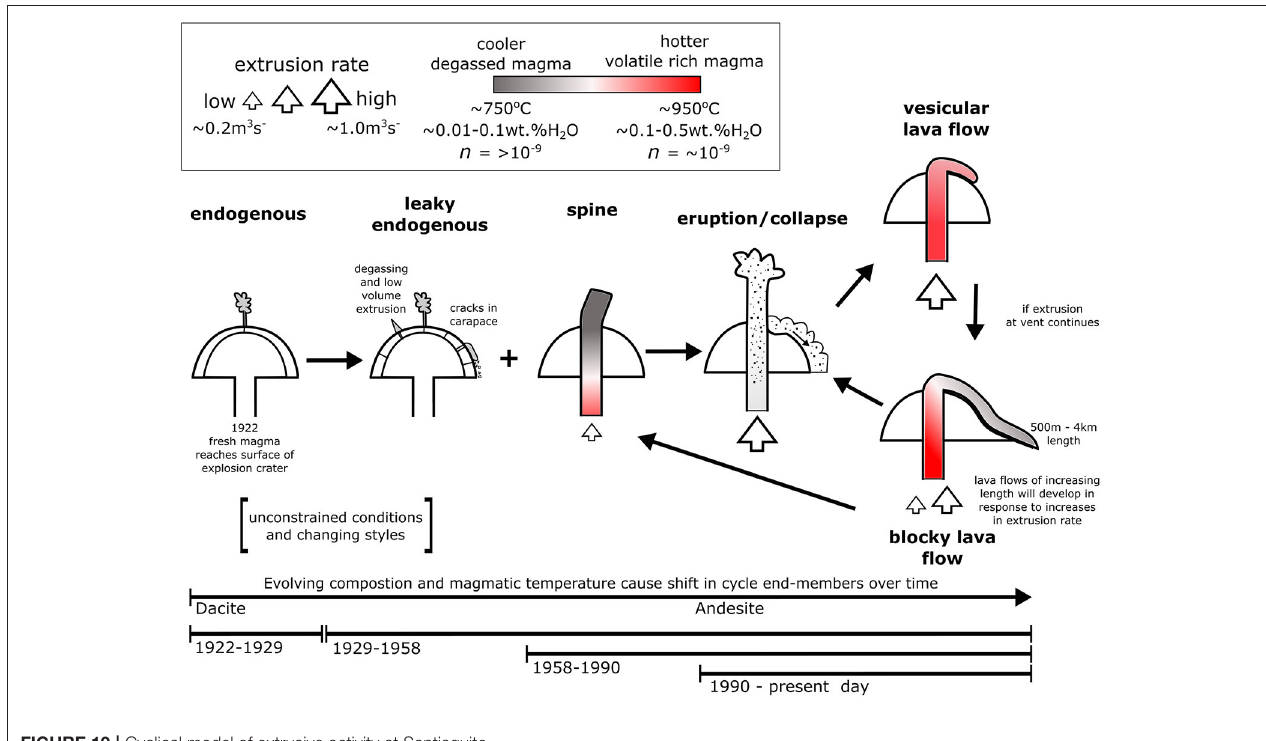
FIGURE 10 | Cyclical model of extrusive activity at Santiaguito.